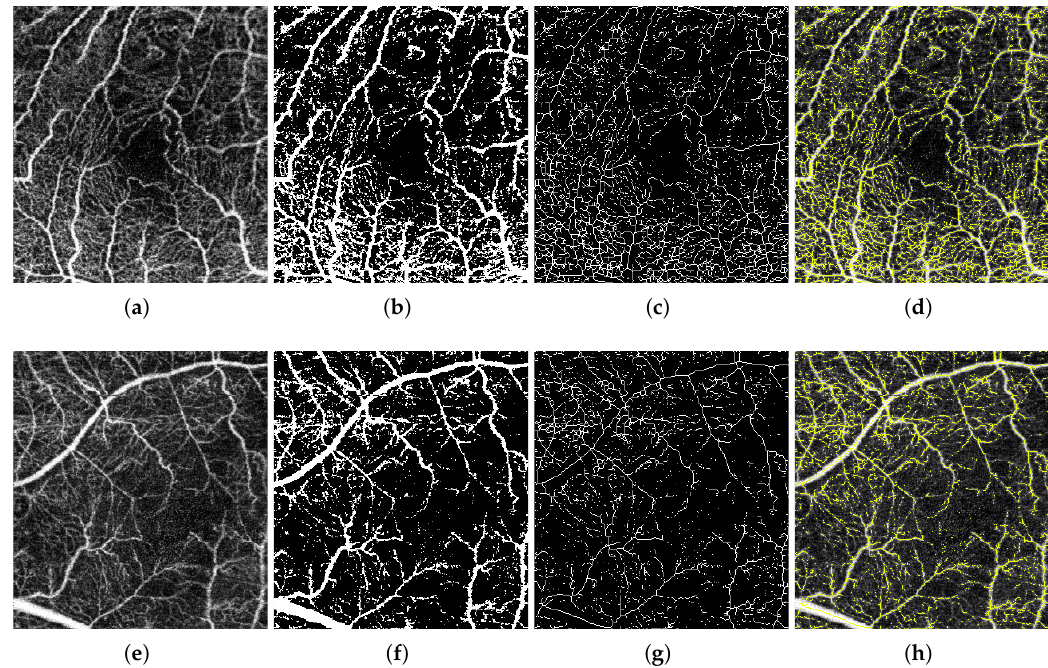
Figure 5. Representative examples of the involved VD extraction steps. ( a , e ) Raw OCTA images. ( b , f ) Resulting binary OCTA images after applying the adaptive threshold. ( c , g ) Skeleton extraction of the binary vascular images. ( d , h ) Graphical representation of the zones that are considered for the VD estimation over the original OCTA